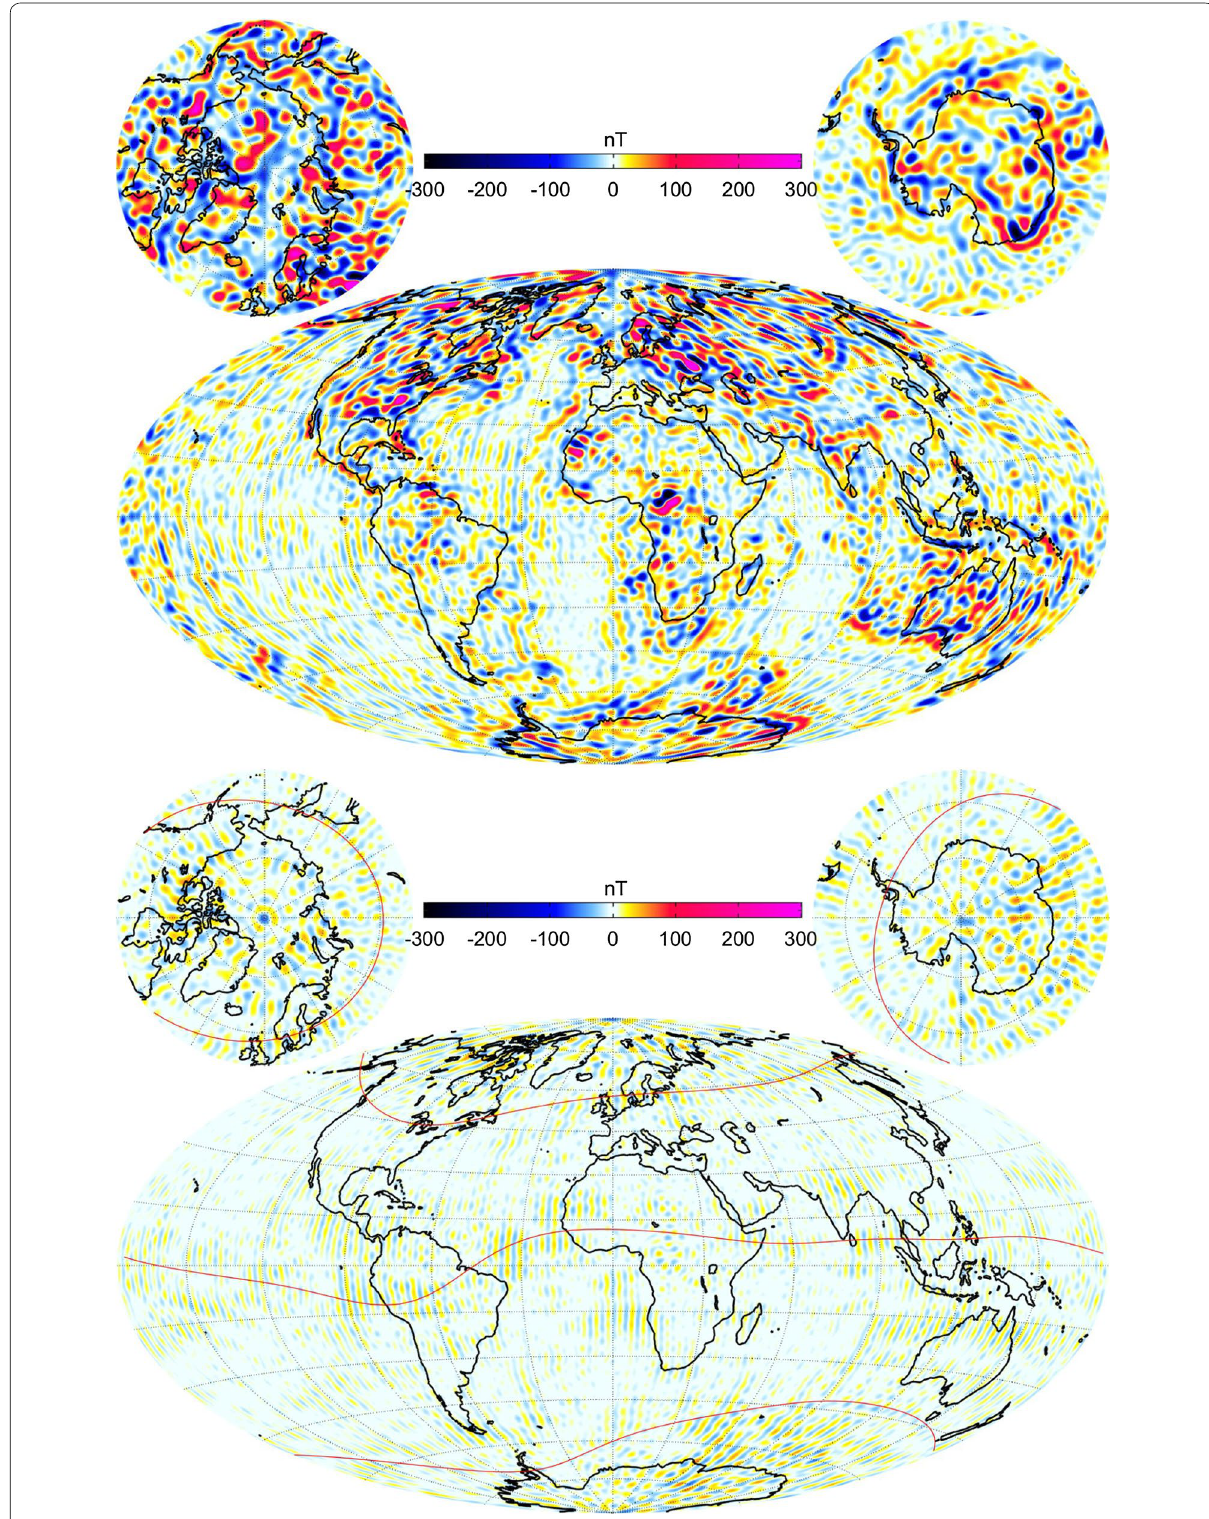
Fig. 8 Top: Map of the CIY4 lithospheric field vertical component Z at Earth’s surface (ellipsoid WGS84), for SH degrees n = 16 − 100 at epoch 2015.0. Bottom: difference between CIY4 lithospheric field and the LCS‑1 model over the same degree range and at the same epoch as above. Red curves represent QD latitudes of ± 55 ◦ and 0